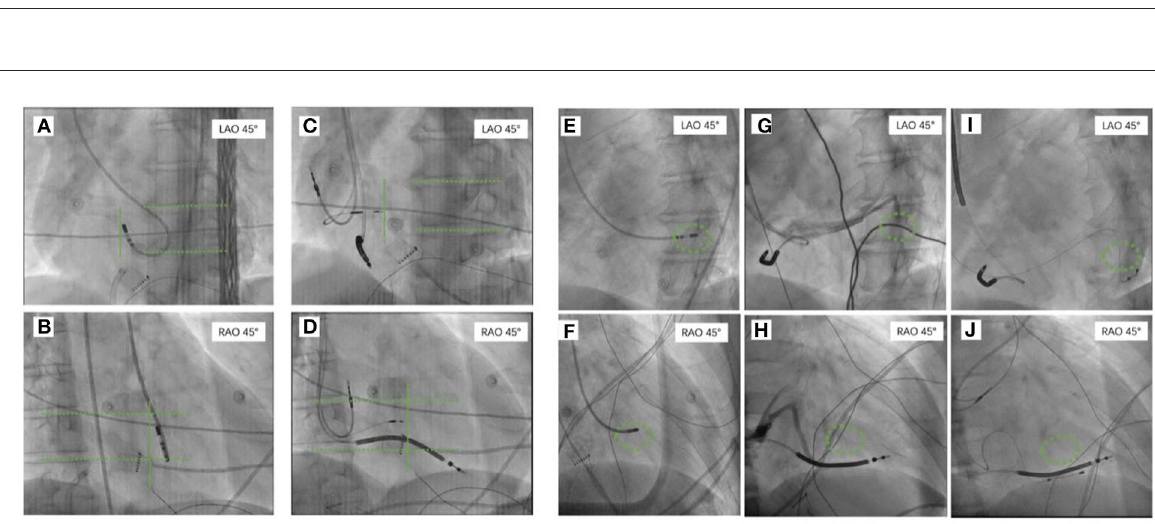
FIGURE4 The tip of the mapping catheter under X-ray recorded at the right anterior oblique (RAO) 30 ◦ position and left anterior oblique (LAO) 45 ◦ . For patients who were planning to undergo LBBAP, the tip of the mapping catheter at the area of the left bundle branch in the left ventricle was recorded at RAO 30 ◦ and LAO 45 ◦ as references (A,B) . The 3,830 electrode was implanted on the right ventricular septum surface corresponding to the tip of the ablation catheter at RAO 30 ◦ and LAO 45 ◦ (C,D) . For patients who were planning to undergo CVP, the tip of the mapping catheter that was placed on the intima surface of the last activation of the left ventricle was recorded at RAO 30 ◦ and LAO 45 ◦ as references (E,F) . Coronary venography was performed to identify the cardiac vein (G,H) closest to the tip of the ablation catheter as the target for implantation of the left ventricular electrode (I,J) . RAO, the right anterior oblique; LAO, the left anterior oblique; CVP, coronary venous pacing; LBBAP, left bundle branch area